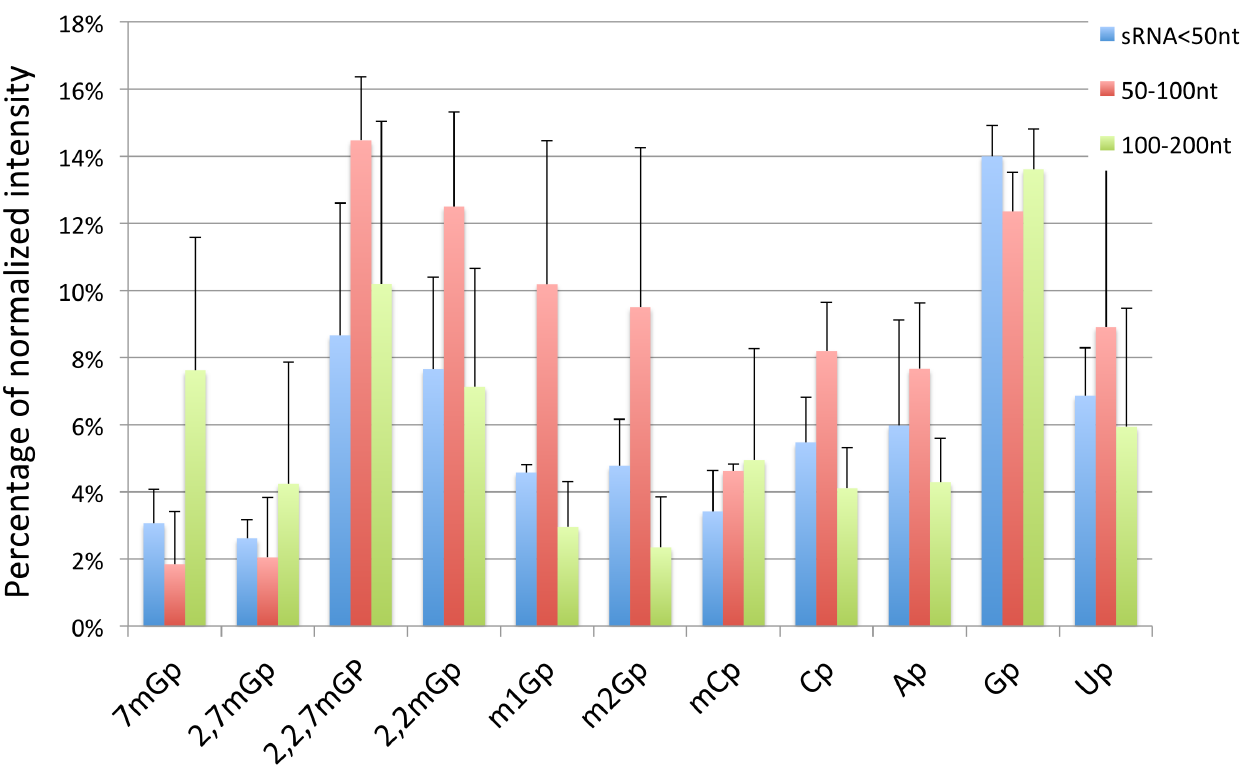
Figure 5. 2,2,7 mGp is the most strongly detected methylguanosine in all length ranges. Quantitative analysis of the 2D-TLC, normalized as a percentage of total intensity for each RNA fraction. Error bars represent the standard deviation on three replicates.